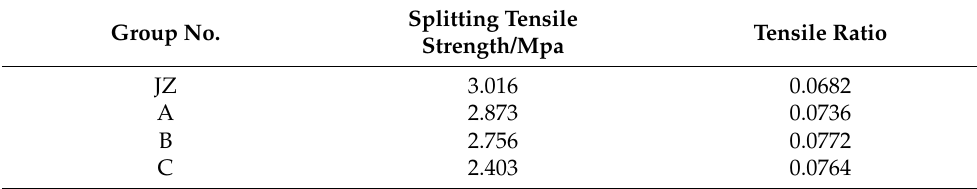
Table 3. Splitting tensile